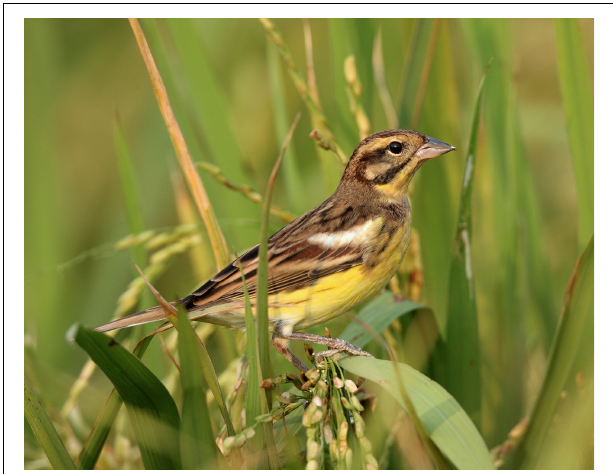
FIGURE 5 | Yellow-breasted bunting Emberiza aureola is the best example of an Asian landbird that has suffered steep declines in the recent decade (Kamp et al., 2015; Image credits: Michelle and Peter